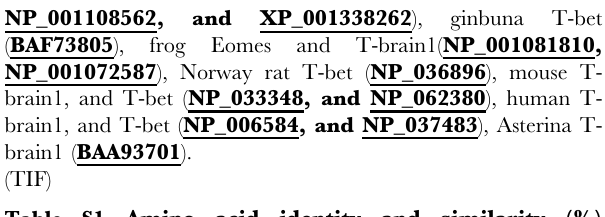
Table S1 Amino acid identity and similarity (%) between different vertebrate